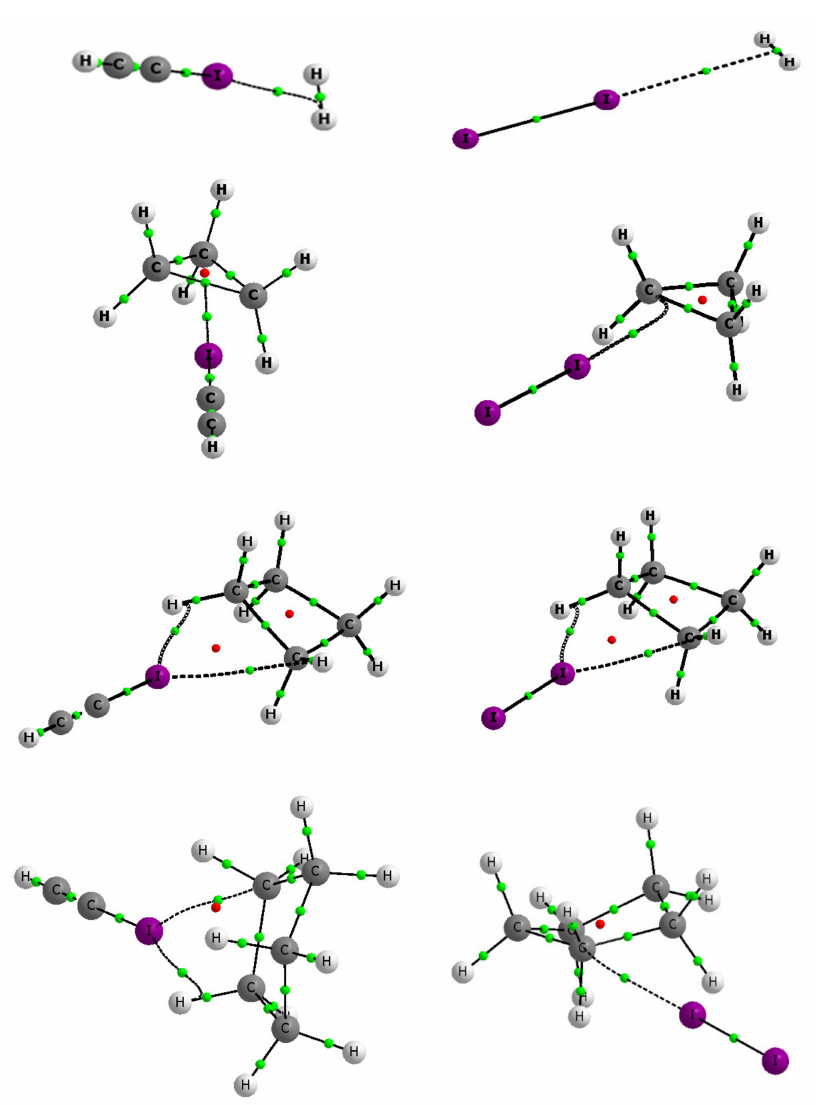
Figure 7. The molecular graphs of the complexes of ICCH and I 2 : big circles correspond to at- tractors; small green circles to bond critical points; small red circles to ring critical points; and solid and broken lines to bond paths. According to left-to-right and top-to-bottom order, the fol- lowing molecules are presented: HCCI · · · H 2 , I 2 · · · H 2 , HCCI · · · C 3 H 6 , I 2 · · · C 3 H 6 , HCCI · · · C 4 H 8